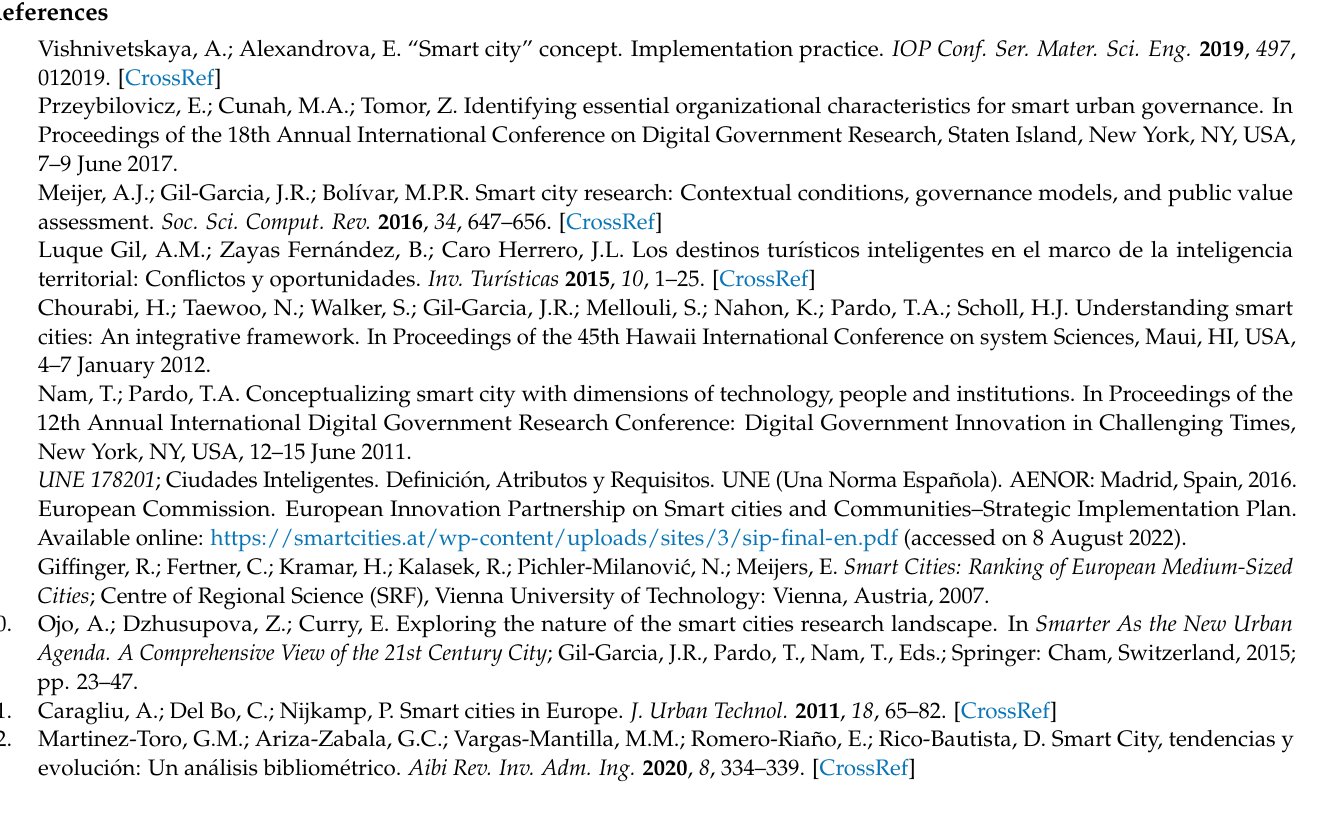
Figure S1: Bibliometric analysis Source and Software, Figure S2: Papers according to a number of authors, Figure S3: Overlay visualization Initial Period, Figure S4: Density items visualization Initial Period, Figure S5: Overlay visualization Development Period, Figure S6: Density items visualization Development Period, Figure S7: Overlay visualization Expansion Period, Figure S8: Density items visualization Expansion